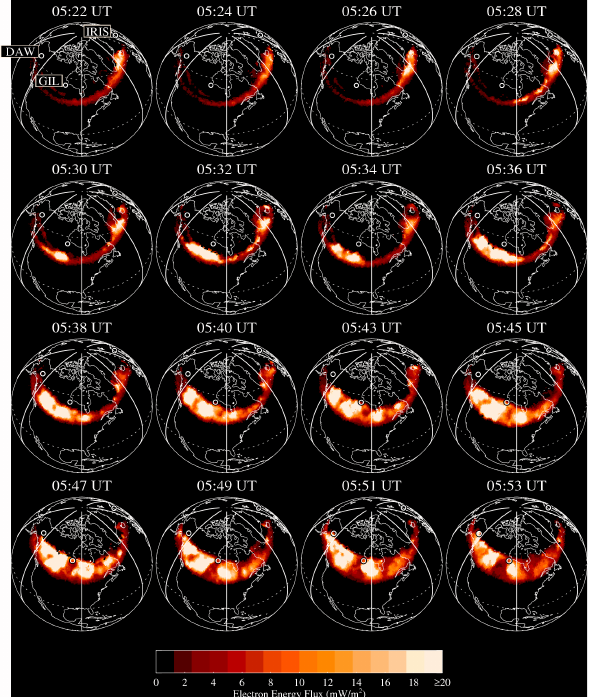
Fig. 12. Maps of Northern Hemisphere FUV derived electron en- ergy flux (mW/m 2 ) on 18 April 2002. These images run from 07:49 UT to 08:35 UT (four minute snapshots) and cover the appar- ent injection at 07:55 UT and the onset at 08:12 UT during event C.